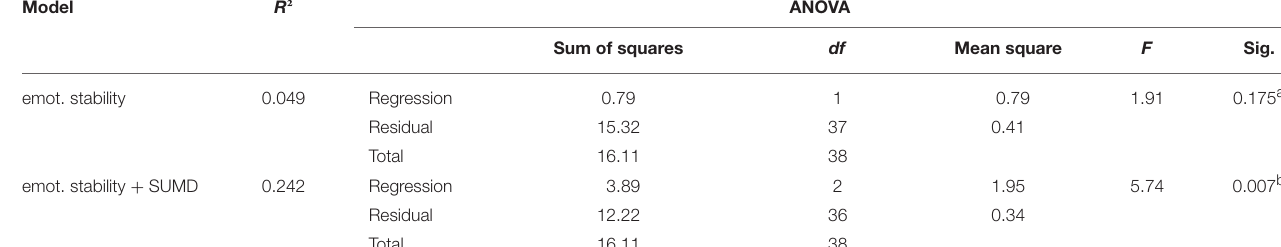
TABLE 1 | Model summary and significance tests of the regression model corresponding to the variables “emotional stability” and “sum of the differences of correct minus incorrect YES answers.”